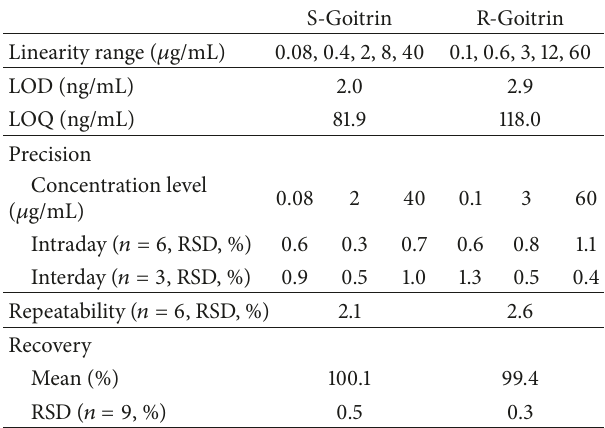
Table 2: Linearity, LOD, LOQ, precision, repeatability, and recovery of the RPLC separation method.